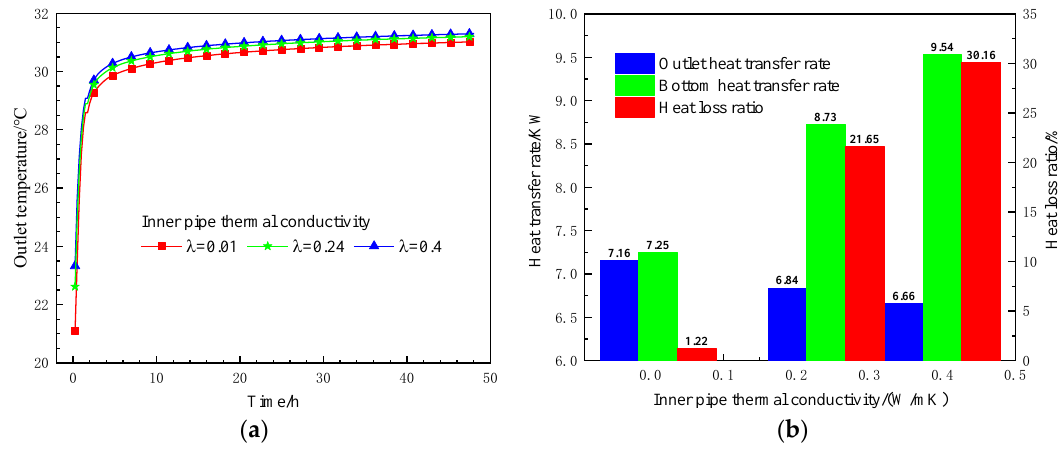
Figure 16. Sensitivity of outlet temperature and heat transfer rate to inner pipe thermal conductivity. ( a ) Sensitivity of outlet temperature to thermal conductivity of inner pipe. ( b ) Sensitivity of heat transfer rate and heat loss ratio to thermal conductivity of inner pipe.